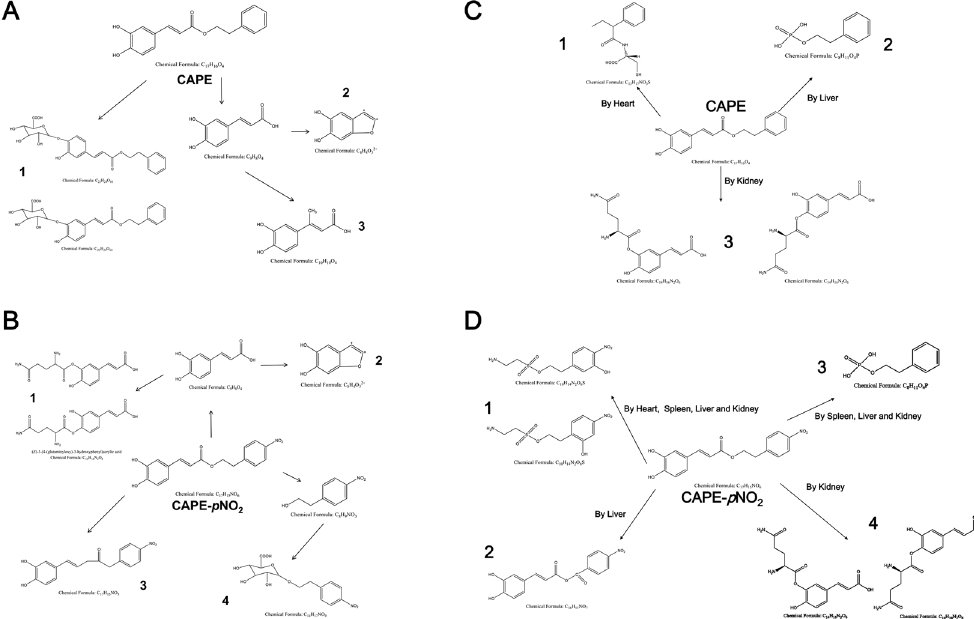
Figure 5. Metabolite analysis of CAPE and CAPE- p NO 2 in HT-29 cells and in tumours, heart, liver, spleen and kidney. Metabolic processes of CAPE (A) and CAPE- p NO 2 (B) in HT-29 cells. Metabolite analysis of CAPE (C) and CAPE- p NO 2 (D) in tumours, heart, liver, spleen and